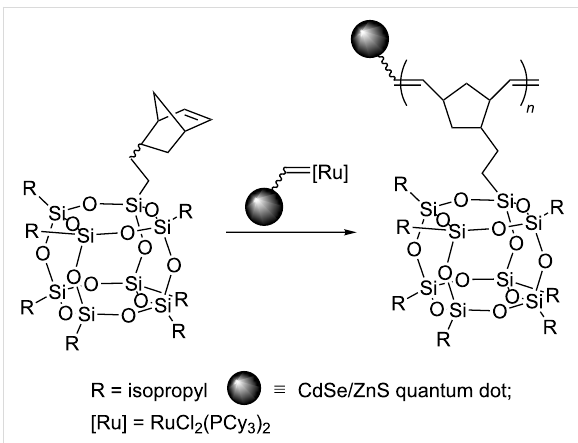
ferent molecular weights and narrow polydispersity homo- or copolymer layers directly onto the quantum dots (Scheme